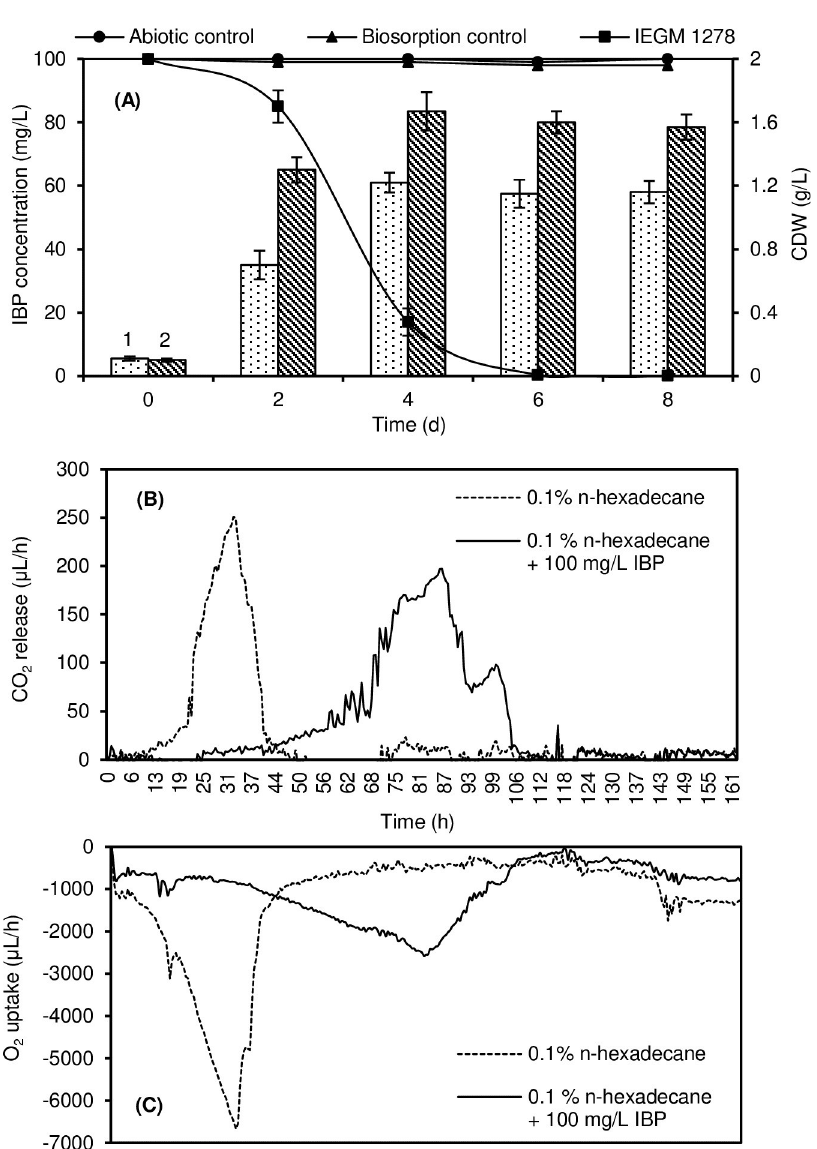
Fig 1. Biodegradation rate of IBP (A), carbon dioxide release (B) and oxygen uptake (C) by R . cerastii IEGM 1278. 1 – dry weight (CDW) of rhodococcal biomass in the presence of IBP and n -hexadecane; 2 –dry weight of rhodococcal biomass in the presence of n -hexadecane. Cells were pre-grown in NB for 3 days. Biodegradation experiments were conducted in the RS medium supplemented with 0.1% n -hexadecane. The graph shows mean values ± SD of three experiments done in